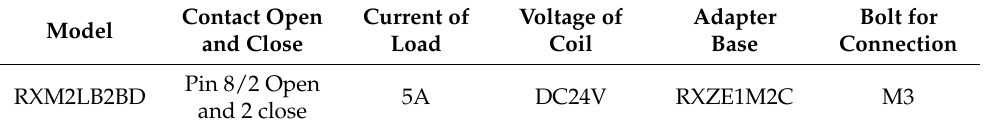
Table 4. Relay parameter